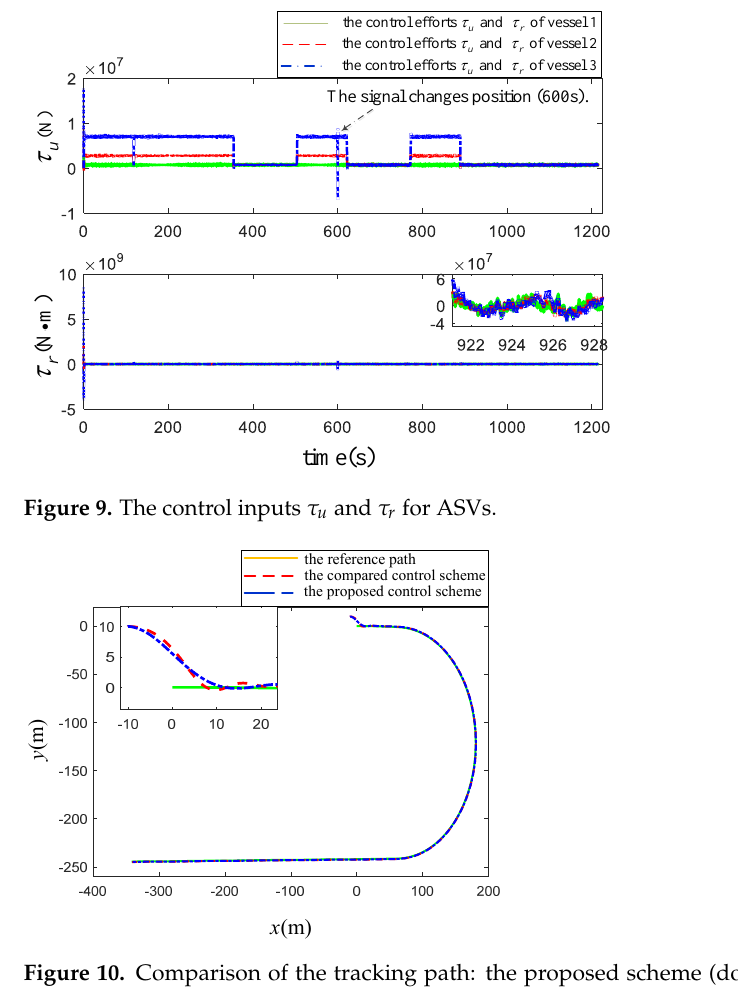
[28] (dashed line). in